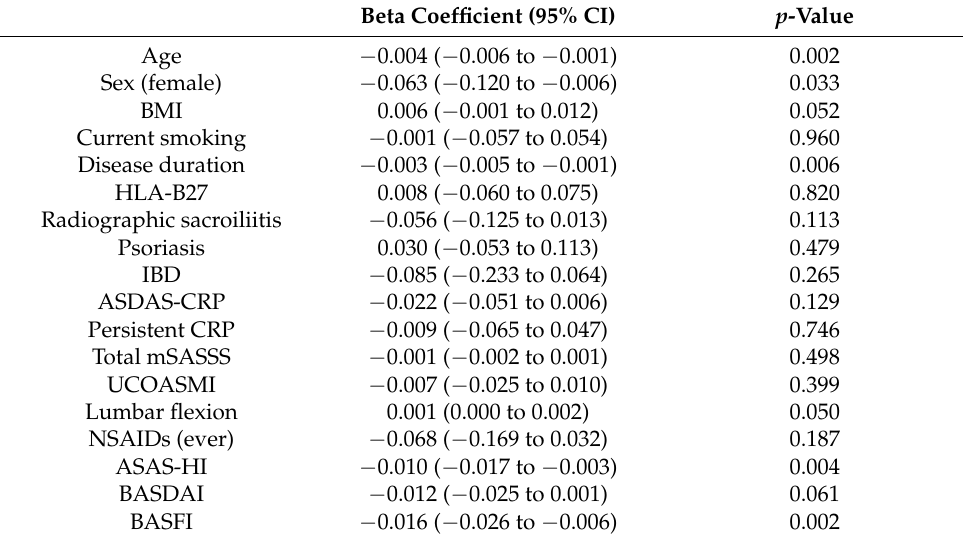
Table 5. Univariate generalised linear regression to evaluate factors associated with femoral neck bone mineral